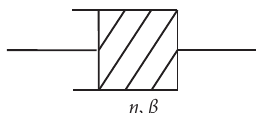
Figure 8: The fractional-order derivative (FOD) viscous body